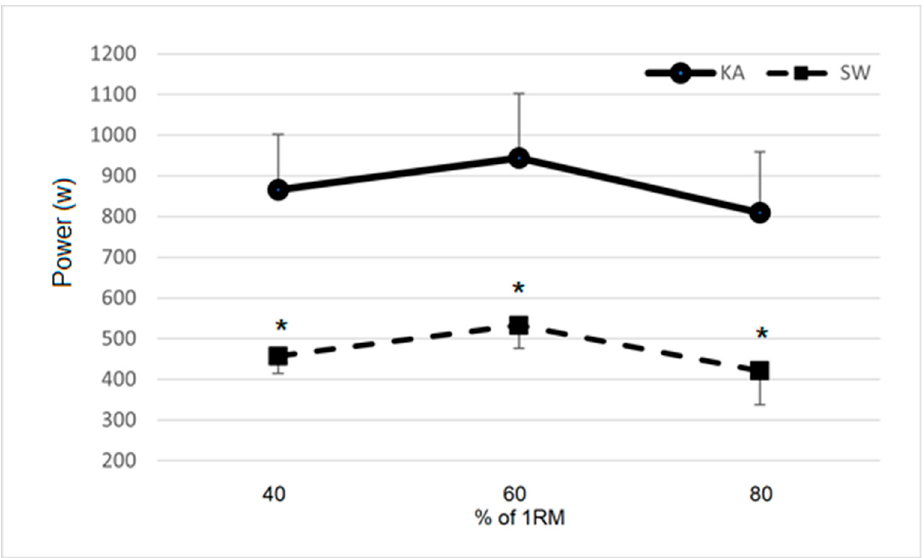
Figure 2. Load–power curve produced at prone bench pull (PU) by the KA and SW groups. KA = kayak group; SW = swimming group; a.u. = arbitrary units. * indicates a significant ( p < 0.05) difference between the groups.